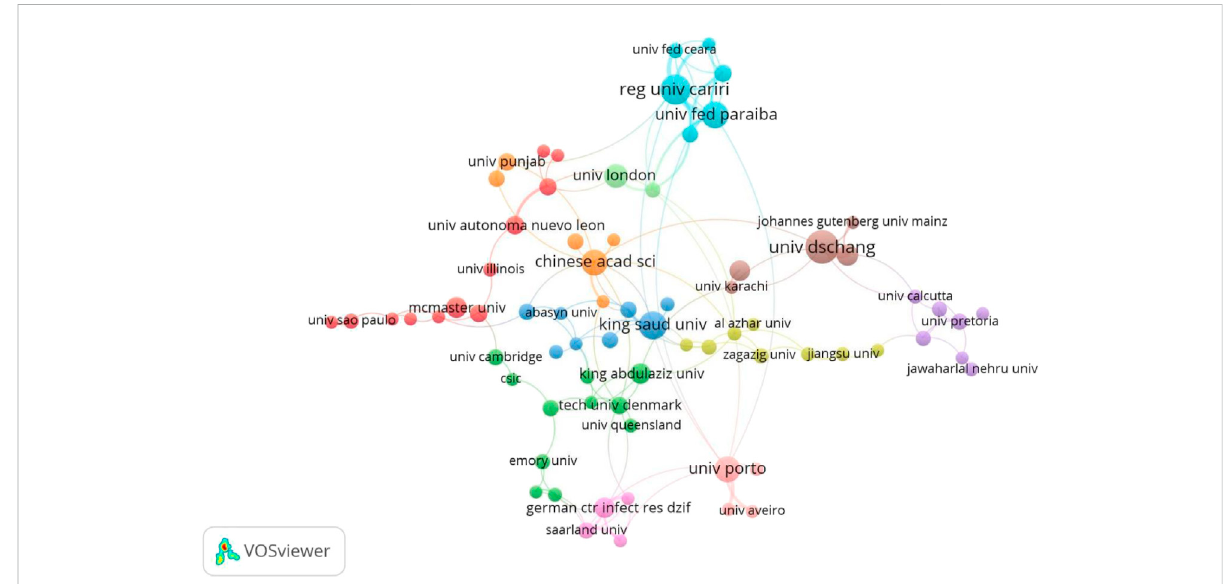
FIGURE 4 Network visualization map of co-authorship among institutions with 5 or more publications.